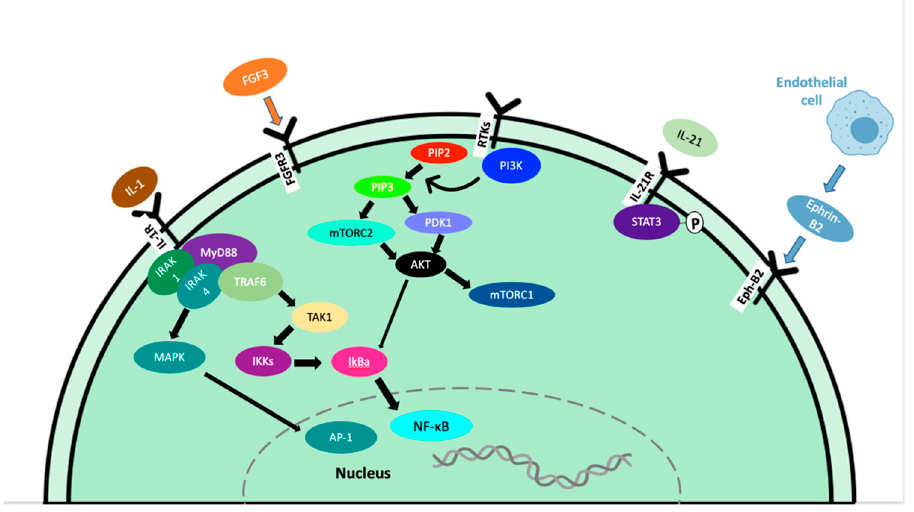
Figure 2. Signaling pathways contributing to tumor progression in WM. Fibroblast growth factor receptor 3 (FGFR3) is a member of the FGFR family that interacts with fibroblast growth factor 3 (FGF3), inducing a cascade of downstream signals that influence cell proliferation. This is well documented in many types of cancer, includ- ing tongue, colorectal, breast, bladder, and oral cancers [22–27]. In WM, the expression of FGFR3 on CD19+ cells from WM patients was greater than the expression on B cells from healthy subjects, and FGFR3 was also overexpressed in the cell lines BCWM.1 and MEC- 1 [28].